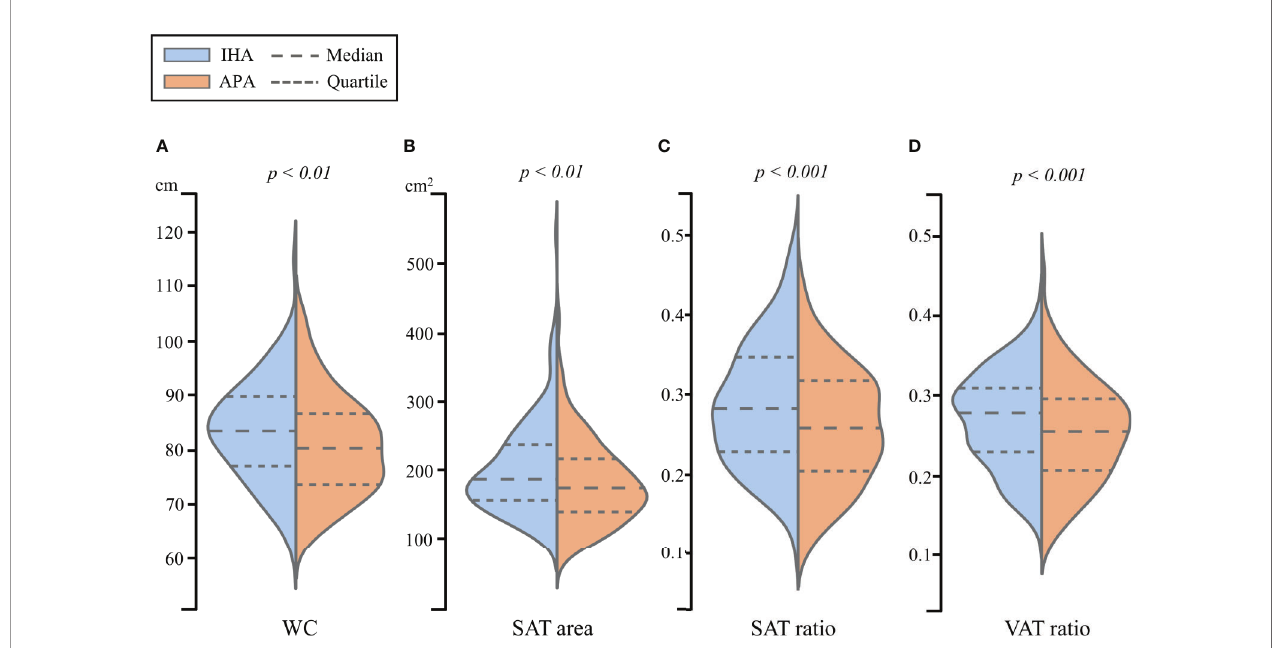
FIGURE 3 | The violin plot of (A) WC, (B) SAT area, (C) SAT ratio and (D) VAT ratio for propensity score matched patients between IHA and